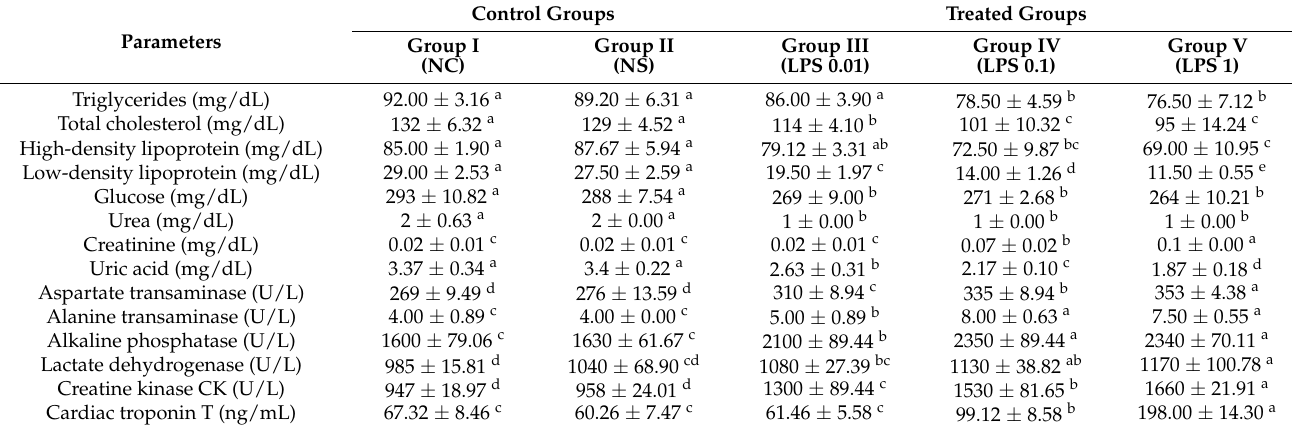
Table 1. Effect of E. coli lipopolysaccharide on the serum biochemical profiles of turkey poults.